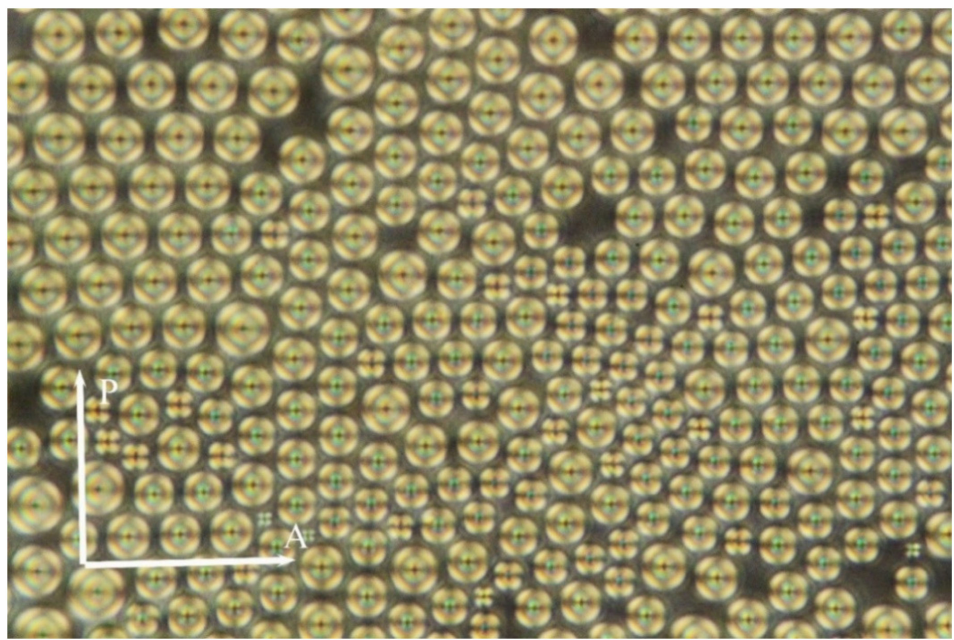
Figure 1. Texture of inclusions in a hybrid system of liquid crystalline compound DL10* with magnetic nanoparticles at 5 ◦ C below the isotropic–SmA phase transition temperature. Orientation of the polariser (P) and the analyser (A) is depicted. The width of the picture is 240 µ